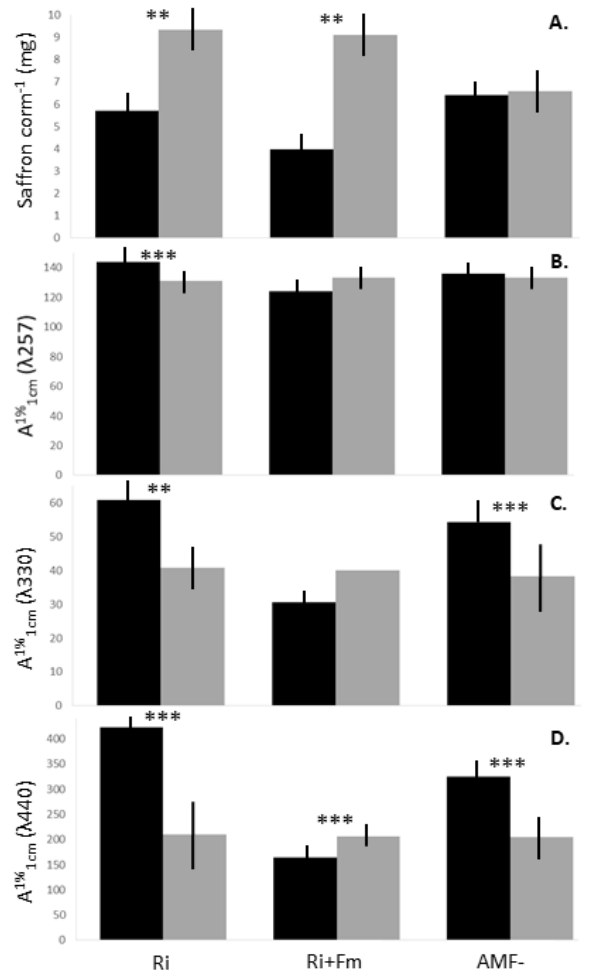
Figure 4. Effects of AMF inoculum consisting of Rhizophagus intraradices alone (Ri), R. intraradices and Funneliformis mosseae (Ri+Fm) or a control (AMF-) on (A.) mg of saffron corm − 1 , (B.) picrocrocin, (C.) safranal, and (D.) crocin of Crocus sativus corms cultivated in soilless (black bars) and open field (grey bars, [12]) conditions. Mean comparisons of each treatment in the two cultivation types were performed using an independent samples t‐test.